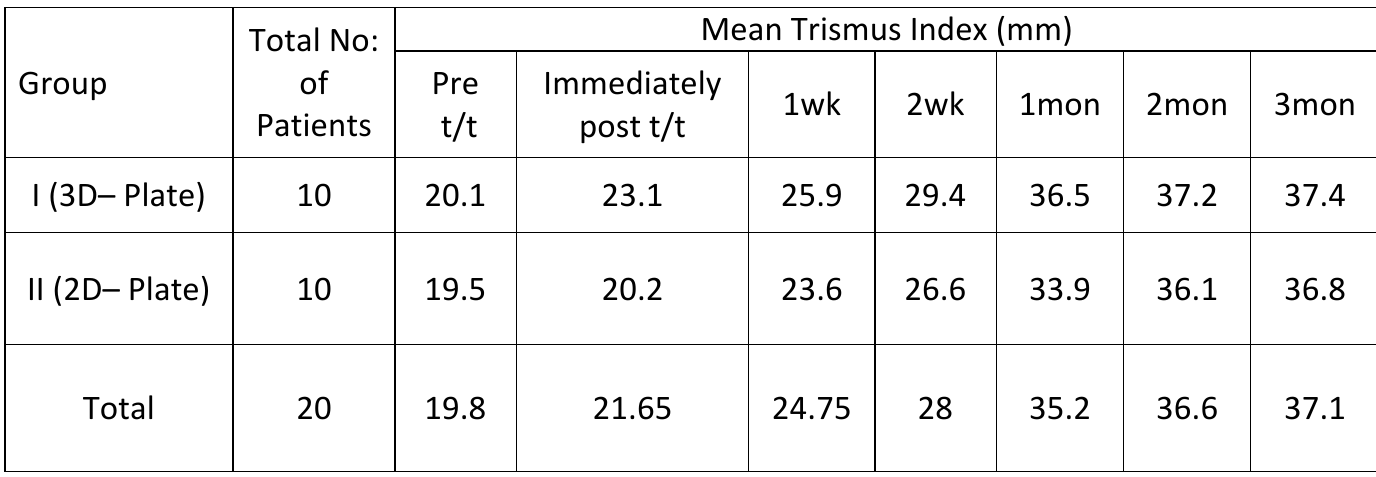
Inter-incisal mouth opening also increased progressively with passage of time. Mean mouth opening pre- treatment was 20.1 mm in group 1 Table 6: Mean Trismus Index (Inter incisal opening in mm)